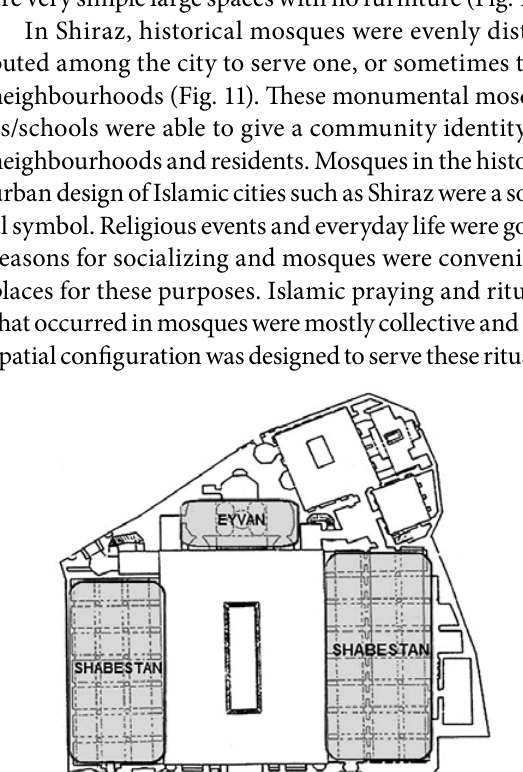
2 Shabestan is a large rectangular nave or hall with many visible piers or columns inside. 3 Eyvan is a semi-outdoor rectangular space, usually vaulted, walled on three sides, with one end entirely open.